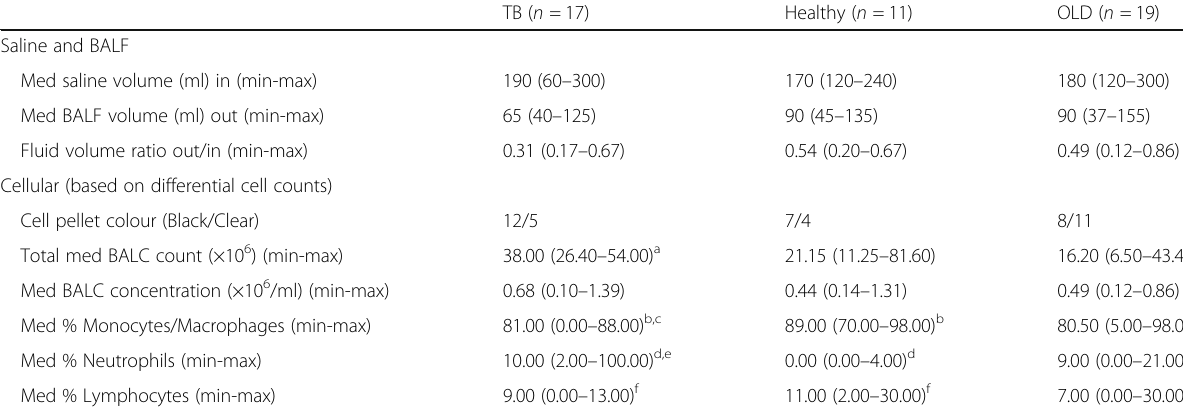
Table 4 Evaluation of BALF and BALC form study participants